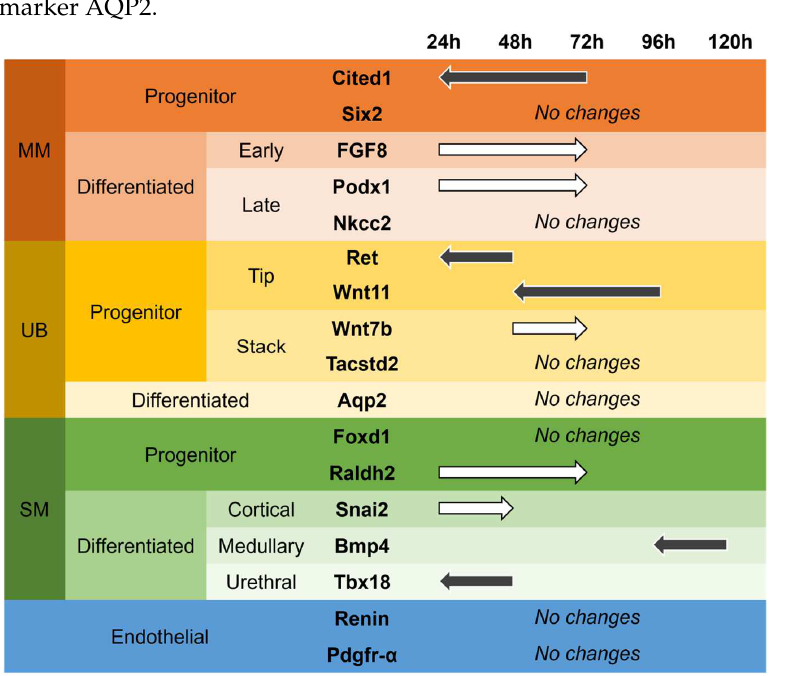
Figure 6. Gene expression of progenitor and differentiation markers of embryonic kidneys. Heatmap showing hierarchically clustered gene expression data of progenitor and differentiation markers of embryonic kidneys in hypoxic culture, compared to normal condition. Gene expression is presented for 24 h, 48, 72 h, 96 h, and 120 h. Genes that show higher expression in hypoxic condi- tion than in normal control are in red, green is associated with a reduction in mRNA level.